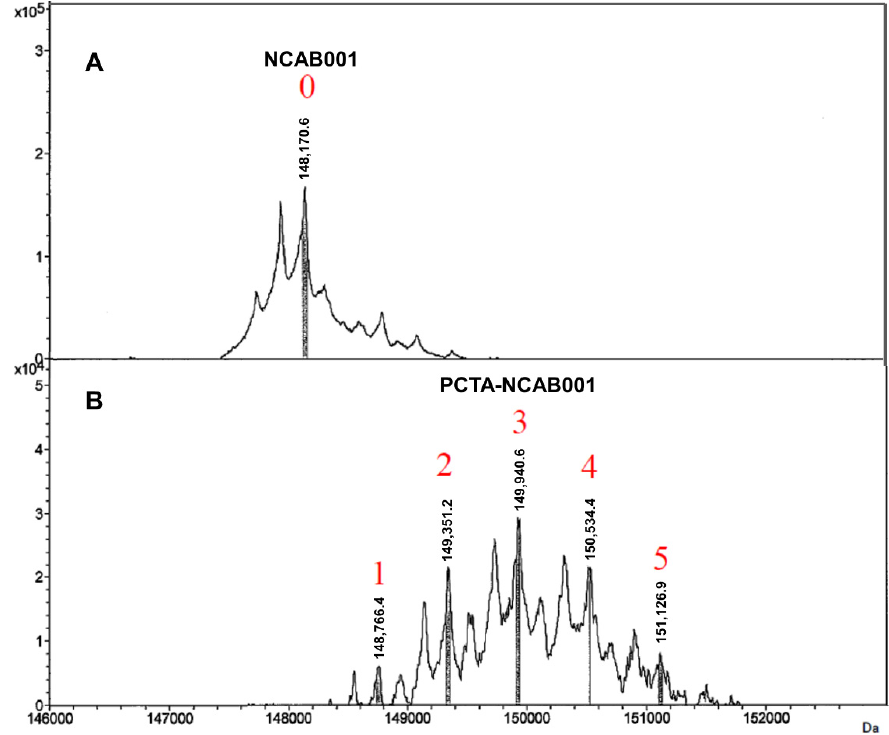
Figure 1. Deconvoluted mass spectra of NCAB001 ( A ) and PCTA-NCAB001 ( B ). The numbers on these spectra denote the numbers of PCTA molecules conjugated to NCAB001 (average of 3, range from 1 to 5).